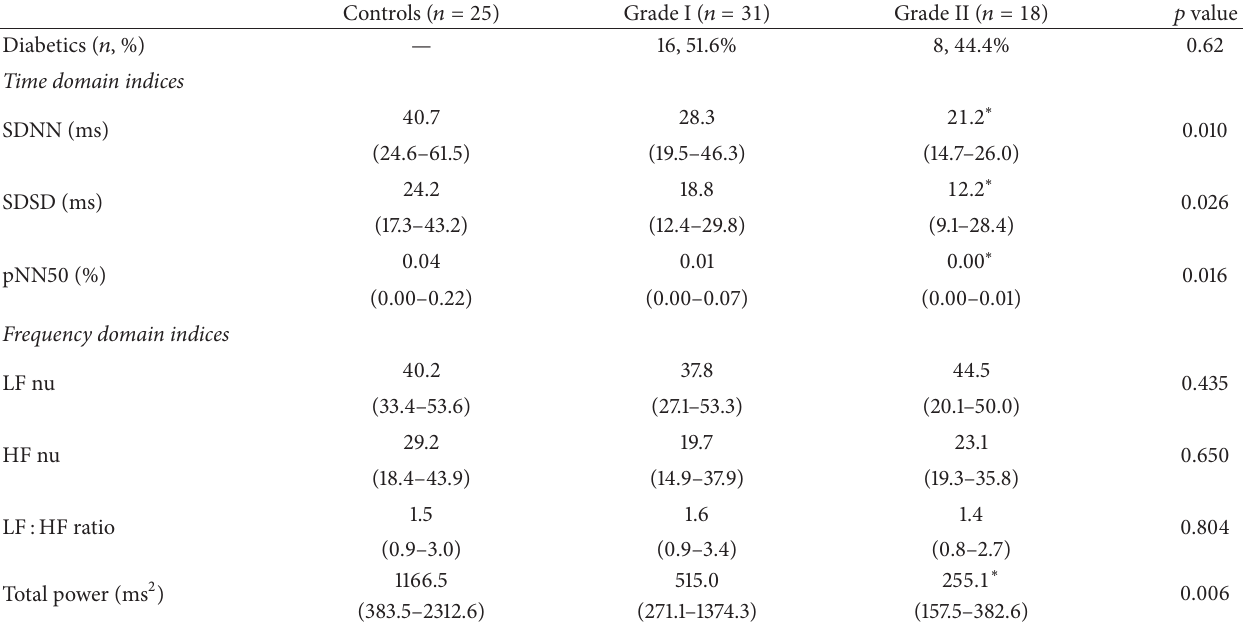
Table 3: Time domain and frequency domain indices of HRV in controls, Grade I and Grade II NAFLD. Controls ( 𝑛 = 25